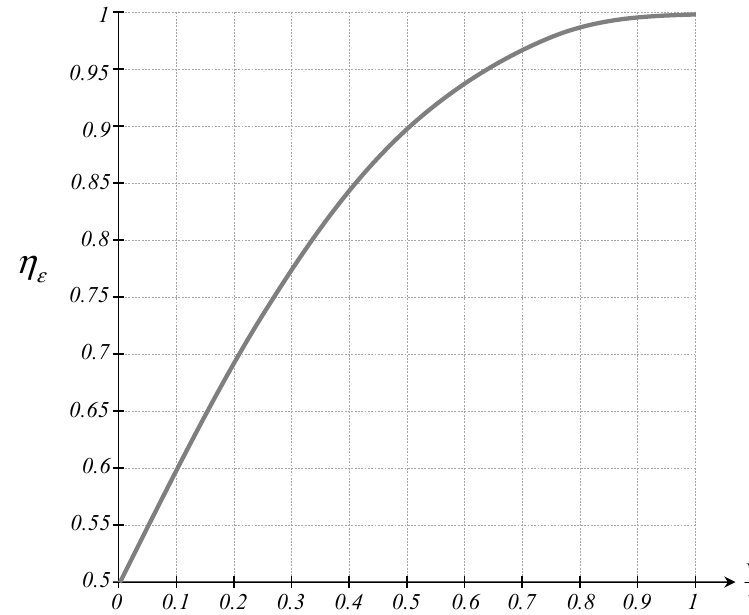
Figure 21. Store energy ratio among the final and the initial condition.